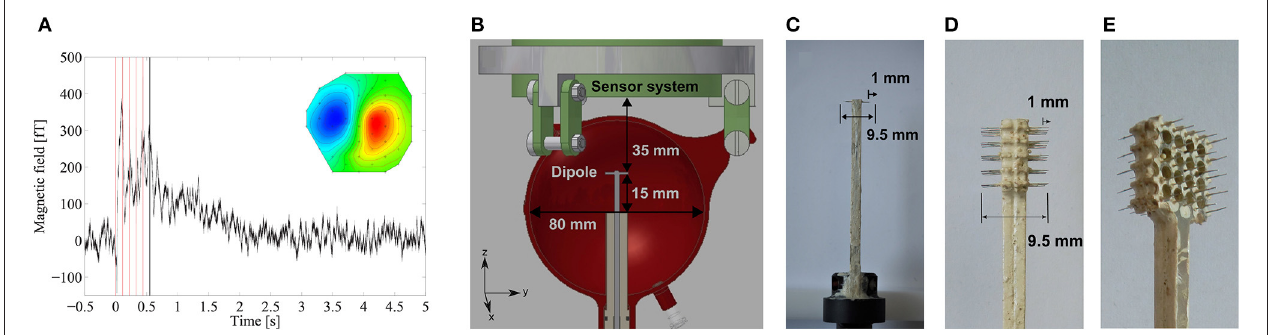
FIGURE 2 | (A) MEG field trace of sustained activity after five electrostimuli of the median nerve (red lines) and the field map averaged from 0.5 to 1.0 s (inset), adapted with permission from Körber et al. [18]. The waveform of variable length (dependent on dcNCI parameters) starts at 0.55 s, as indicated by the black line. (B) Head phantom positioned below the dewar with the integrated single current dipole within a conducting solution. (C) Single current dipole. (D) 5 × 5 dipole grid simulating an extended source. (E) Extended source phantom showing the array of holes facilitating the flow of return currents to avoid cross